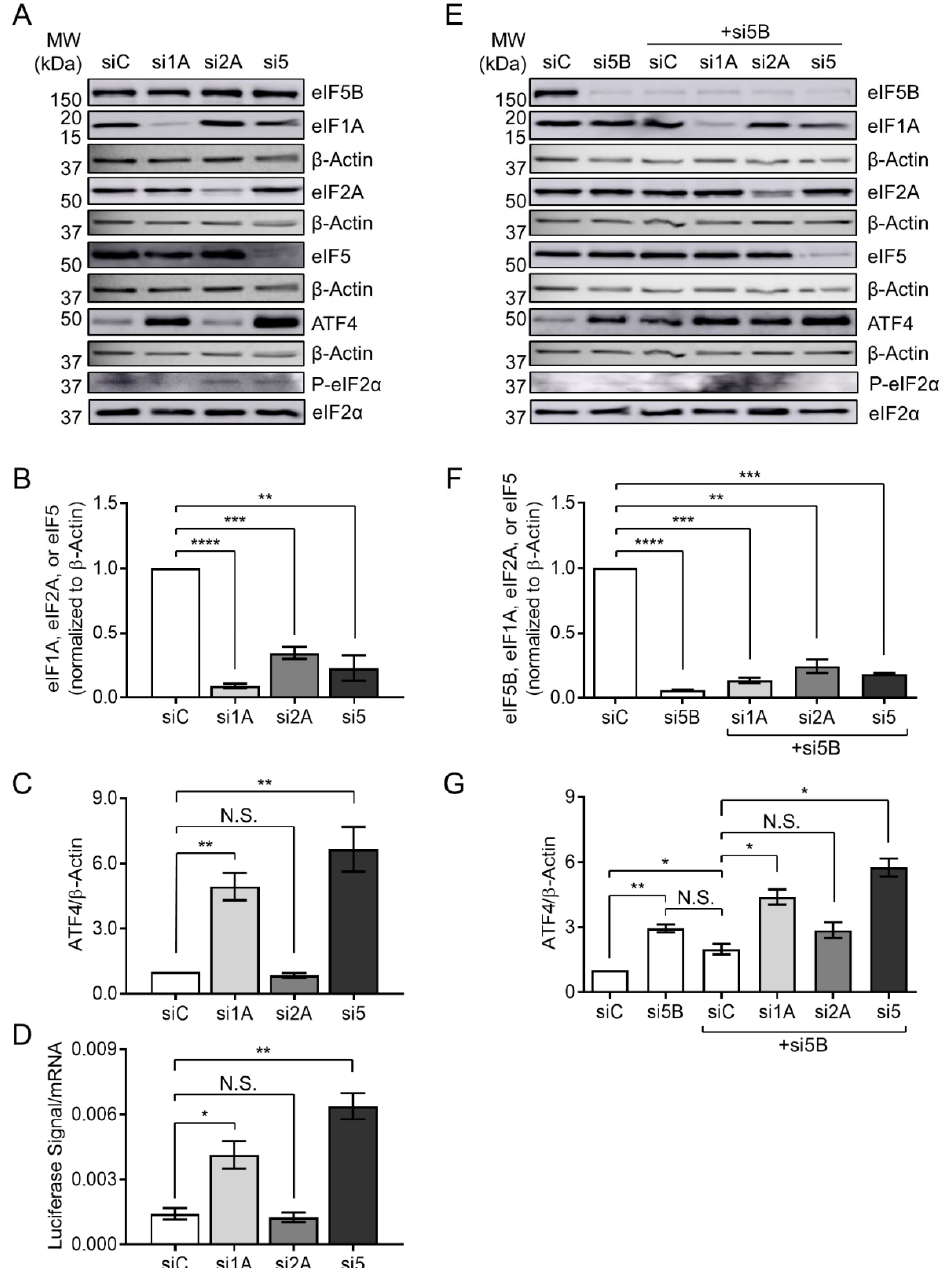
Figure 4. eIF5B cooperates with eIF1A and eIF5, but not eIF2A, to repress ATF4 translation. ( A ) HEK293T cells were transfected with a control siRNA (siC) or siRNAs targeting eIF1A (si1A), eIF2A (si2A), or eIF5 (si5) and subjected to immunoblotting as described for Figure 1. Representative images are shown of immunoblots probing for eIF1A, eIF2A, eIF5, ATF4, eIF2α, P-eIF2α, or β-Actin (internal control). ( B ) Quantitation of eIF1A, eIF2A, or eIF5, each normalized to β-Actin. ( C ) Quantitation of ATF4, normalized to β-Actin. ( D ) HEK293T cells were depleted of eIF1A, eIF2A, or eIF5, as above, before measuring expression of the WT ATF4-luc reporter construct as in Figure 3B. ( E ) HEK293T cells were transfected with a control siRNA (siC), an siRNA targeting eIF5B (si5B), or si5B in combination with siC, si1A, si2A, or si5. Representative immunoblots probing for eIF5B, eIF1A, eIF2A, eIF5, ATF4, eIF2α, P-eIF2α, or β-Actin (internal control), are shown. ( F ) Quantitation of eIF5B, eIF1A, eIF2A, or eIF5, each normalized to β-Actin. ( G ) Quantitation of ATF4, normalized to β-Actin. Data are expressed as mean ± SEM for 3 (panels B – D ) or 2 (panels F , G ) independent biological replicates. * p < 0.05; ** p < 0.01; *** p < 0.001; **** p < 0.0001.